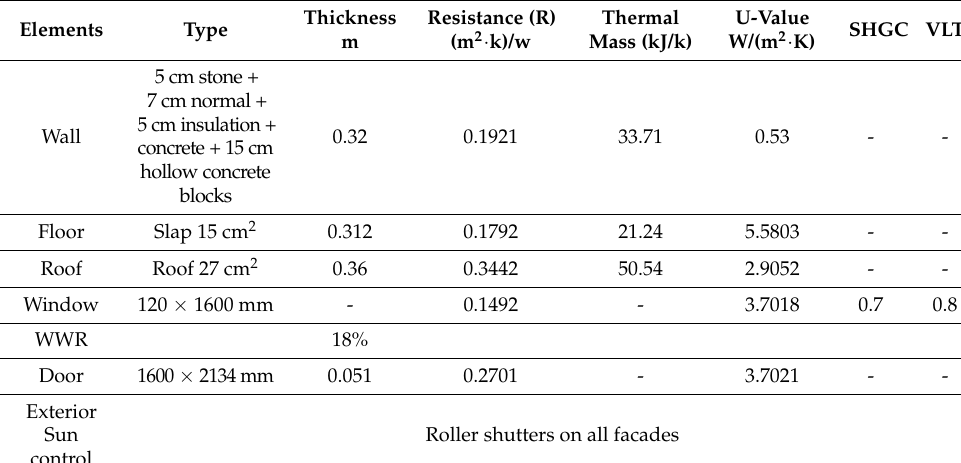
Table 6. Envelope components’ analytical properties (Case 3).